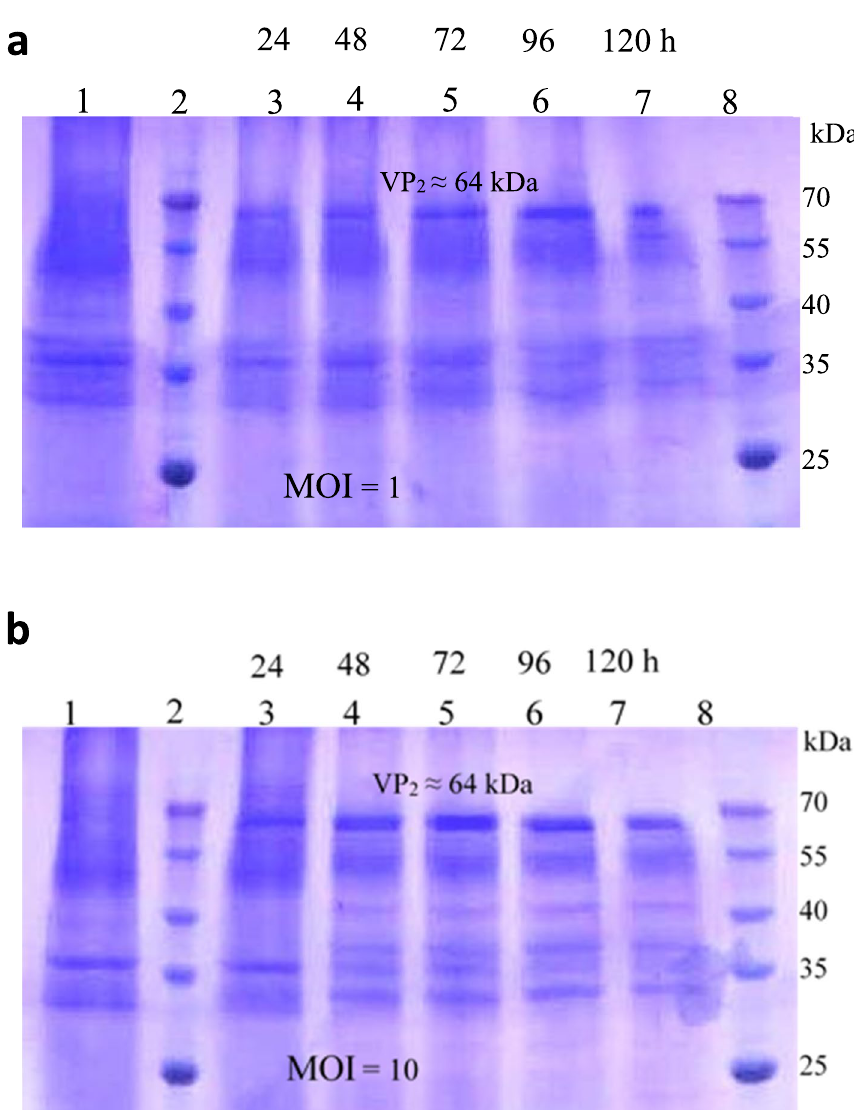
Fig. 3 SDS-PAGE results of the proteins extracted from the Sf9 cells infected by the recombinant baculoviruses encoding VP2. a The proteome of the cells infected with MOI of 1 (pfu/cell) and b the proteome of the cells infected with MOI of 10 (pfu/cell). Lane 1: The cell control, lanes 2 and 8: Molecular weight marker (Fermentas) and lanes 3–7: The protein samples taken at the harvest times of 24, 48, 72, 96, and 120 hpi, and the expected band ( ⁓ 64 kDa) corresponding to the recombinant expressed